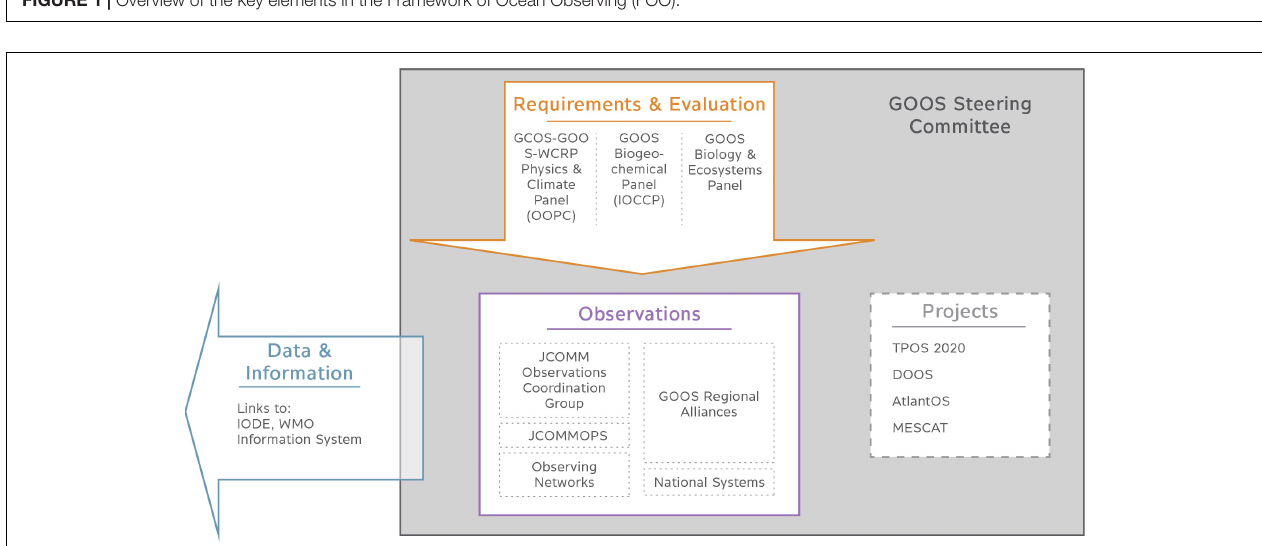
FIGURE 1 | Overview of the key elements in the Framework of Ocean Observing (FOO).